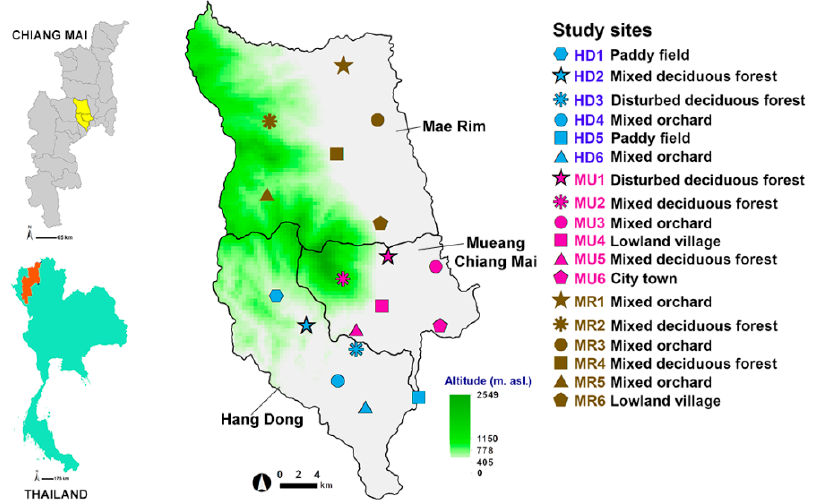
Figure 1. Map of Thailand showing three sample districts (Mueang Chiang Mai, MU; Mae Rim, MR; and Hang Dong, HD) and 18 sample locations. Green shading indicates a mountainous zone.